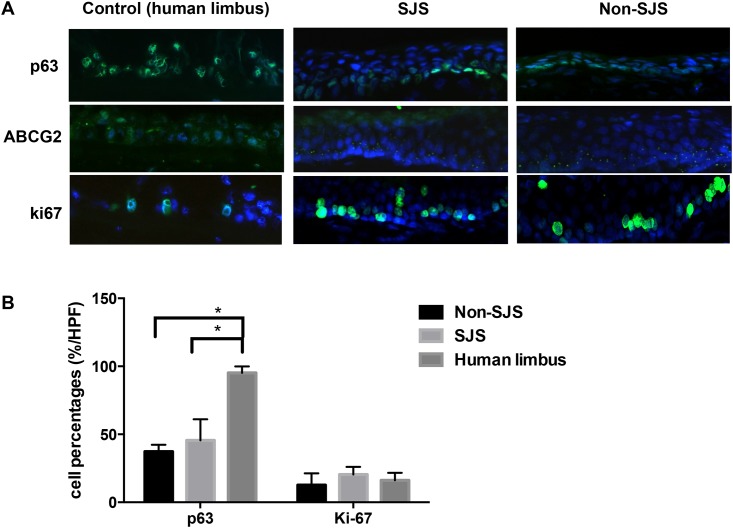
Characteristics of the progenitor cell expression with Stevens—Johnson syndrome (SJS) and non-SJS COMECs on day 7 post-transplantation.(A) Cornea with COMECs from both SJS and non-SJS subjects highly expressed p63, ABCG2, and Ki-67 (X400). (B) Percentage of p63- or Ki-67-positive cells in the corneas transplanted with SJS-COMECs was not different from that in the corneas transplanted with non-SJS-COMECs (p>0.05, Mann-Whitney U test). The percentage of p63 was lower in both COMECs-transplanted corneas from SJS and from non-SJS subjects than that in normal human limbal tissues as control (p<0.05, Mann-Whitney U test). The control indicates normal limbal tissues of human.